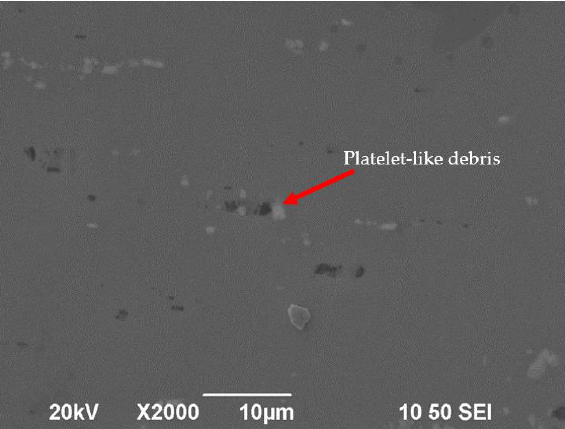
Figure 12. Platelet-like debris on the surface after lapping process (rotational speed 1000 rpm, time 15 min, slurry: SiO 2 ).